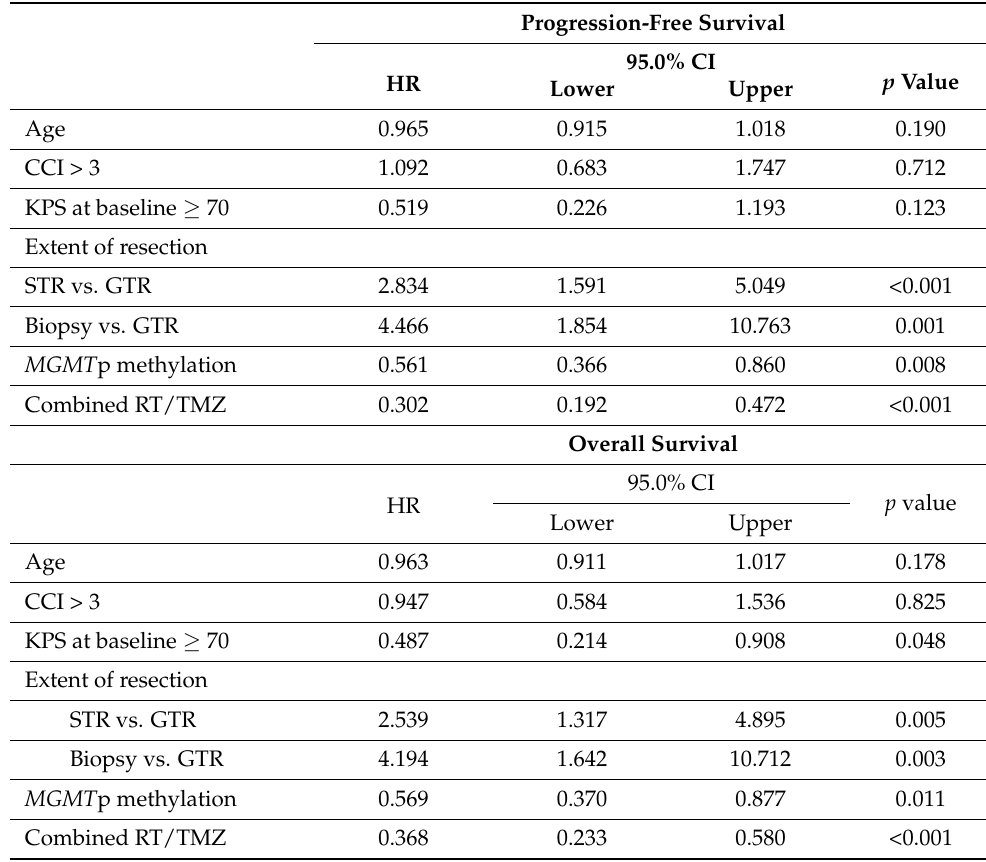
Table 9. Multivariable Analysis on Progression-Free Survival and Overall